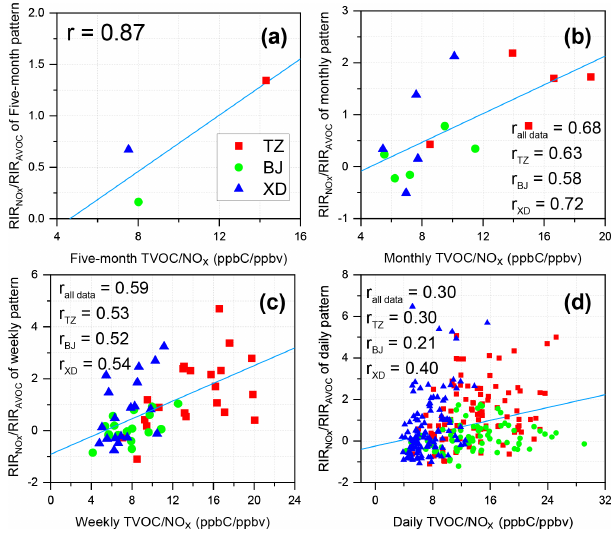
Figure 5. The correlations of TVOC / NO x with / RIR AVOC at multiple patterns of timescale at the RIR NO x three sites in